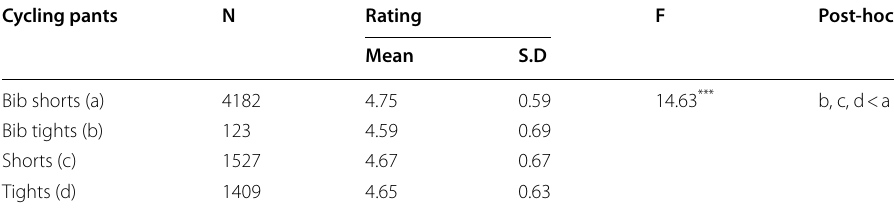
Table 2 Differences of the rating of reviews on cycling pants